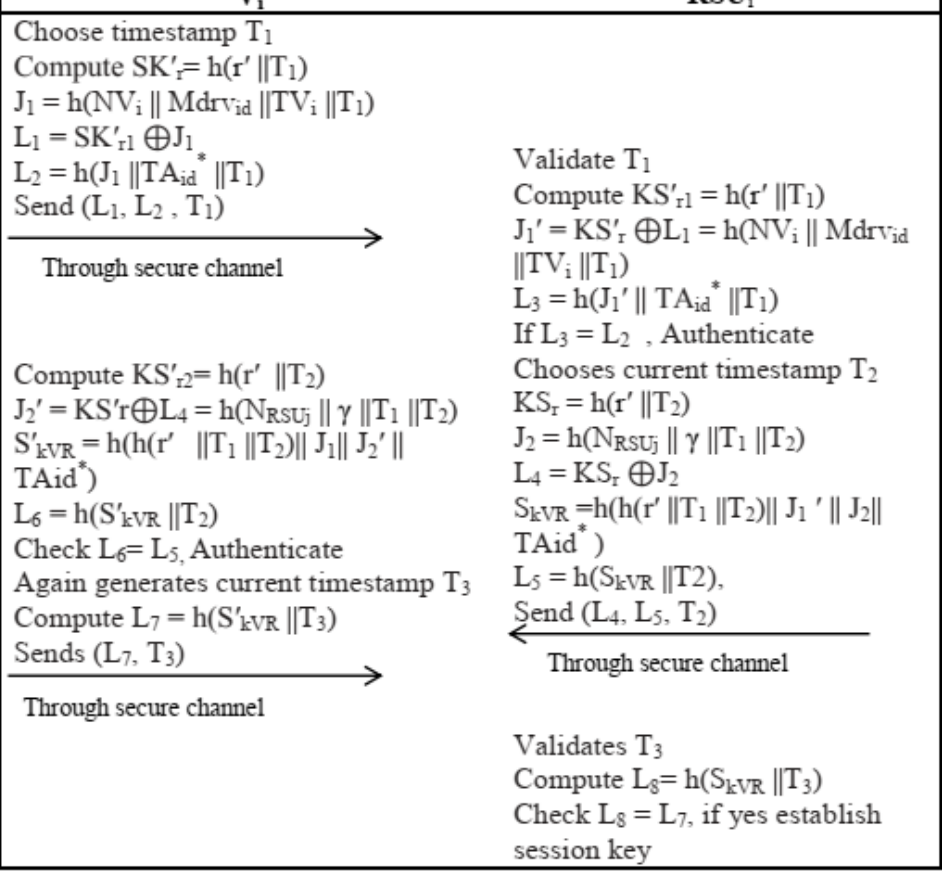
Figure 5. V2RSU Authentication and key establishment phase.